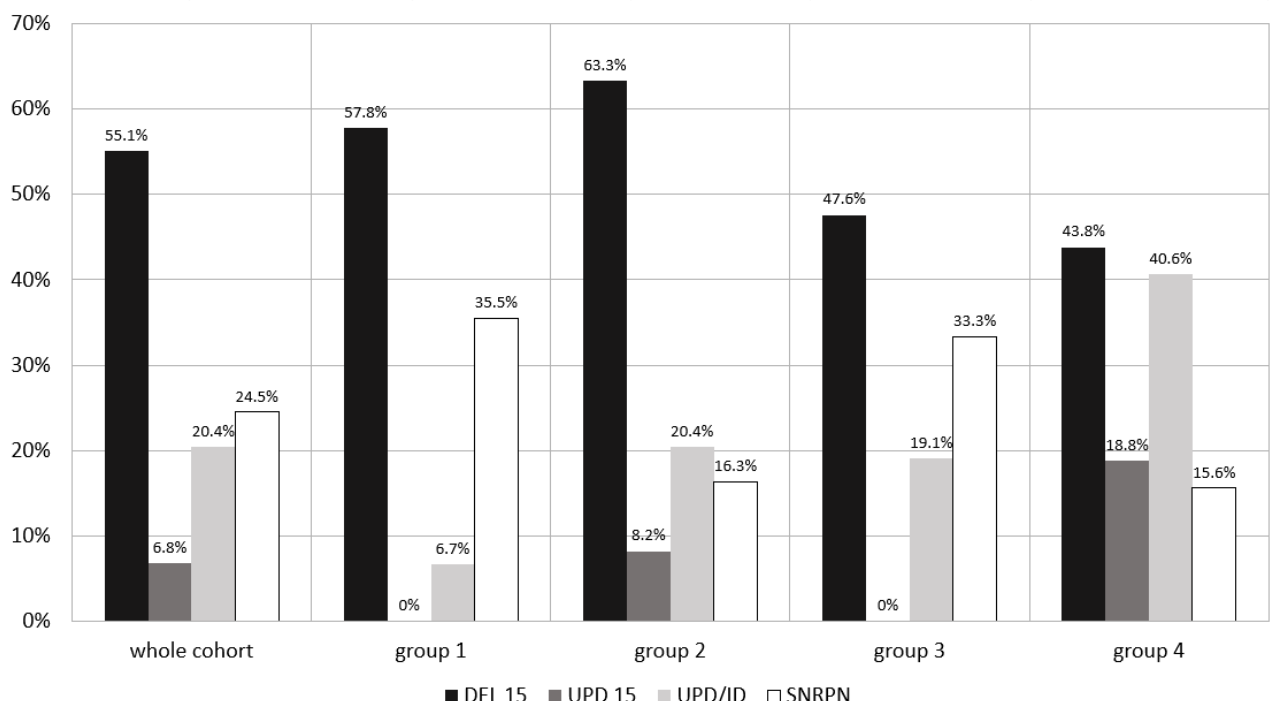
Figure 1. Frequency of molecular types of diagnosis in the whole study cohort and the separate groups (percentage). Group 1: age ≤ 2 years; group 2: age >2 and ≤ 4.5 years; group 3: age >4.5 and ≤ 8 years; and group 4: age >8 years of life. DEL 15—deletion of chromosome 15q11-13; UPD 15—uniparental disomy; ID—imprinting defect; SNRPN—abnormality in methylation pattern of SNRPN.